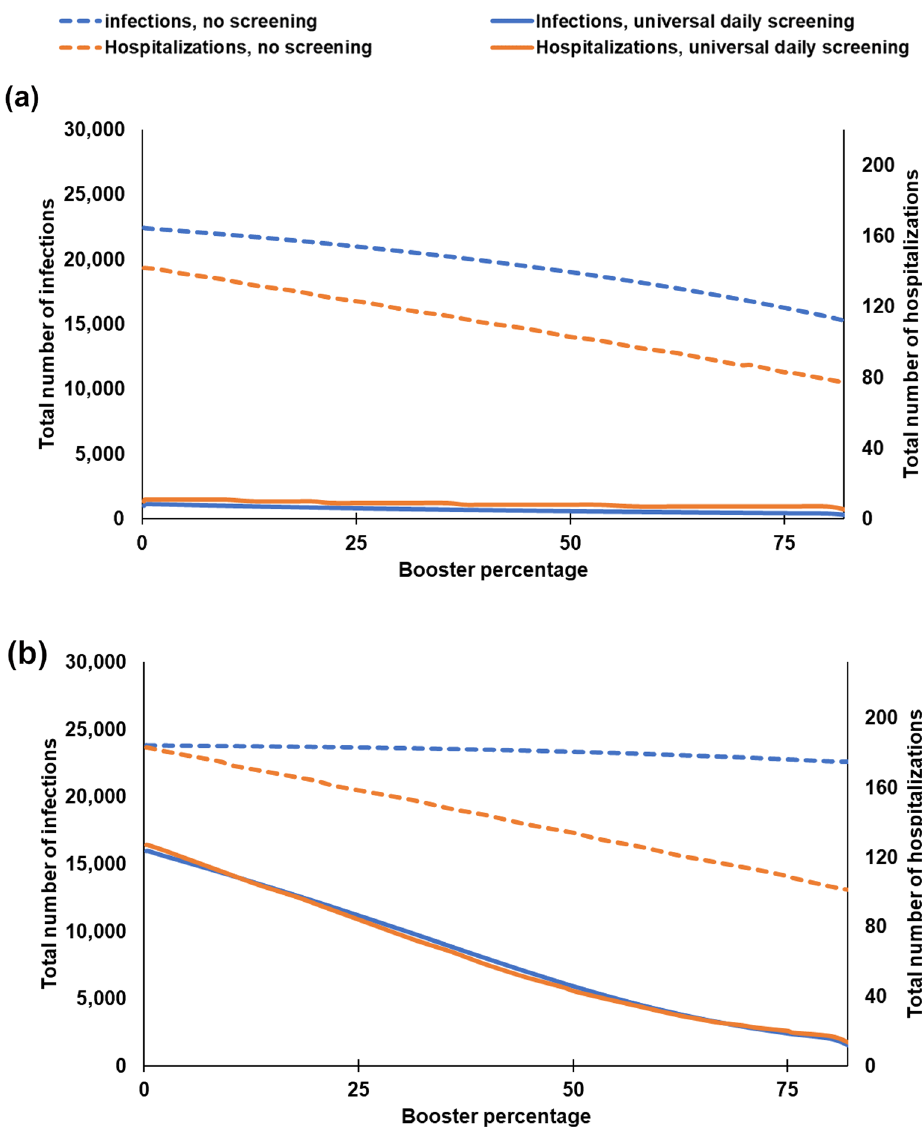
Figure 5. Total number of infections and hospitalizations with respect to the booster coverage under no screening and universal daily screening when 18% is unvaccinated and the remaining is either boosted or vaccinated, and the screening compliance is 100% ( η = 100% ). ( a ) ω 0 = 50% case, ( b ) ω 0 = 95%